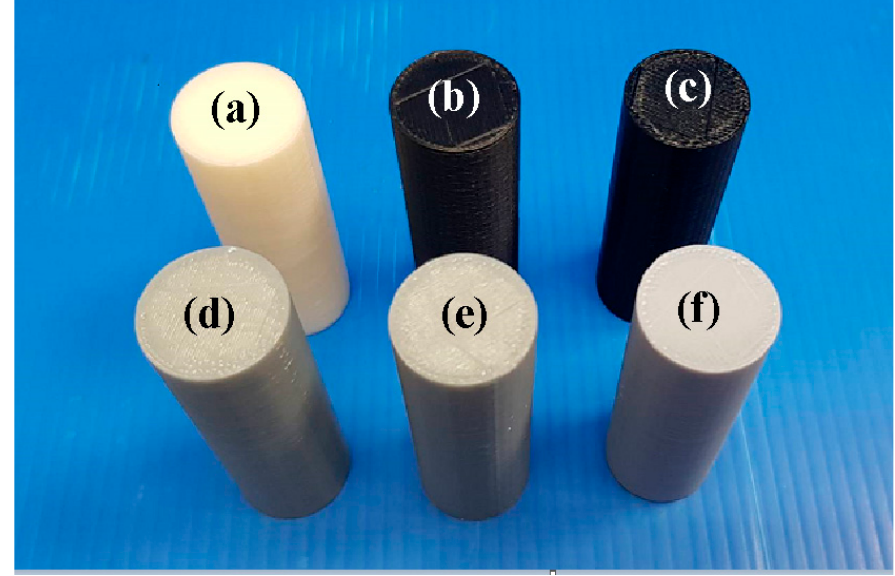
Figure 5. FRW specimens fabricated with ( a ) PLA, ( b ) ABS, ( c ) 10% GF reinforced PLA, ( d ) 10% CF reinforced PLA, ( e ) PA, and ( f ) PC feedstock filaments.